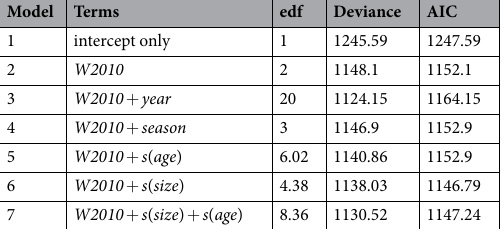
Table 2. Model comparison for hazard regression for seasonal mortality. W2010 captures the singular winter period of 2010/11. s eason is a two-level factor that distinguishes the summer periods from the non-summer periods. All other variables as in Table 1.